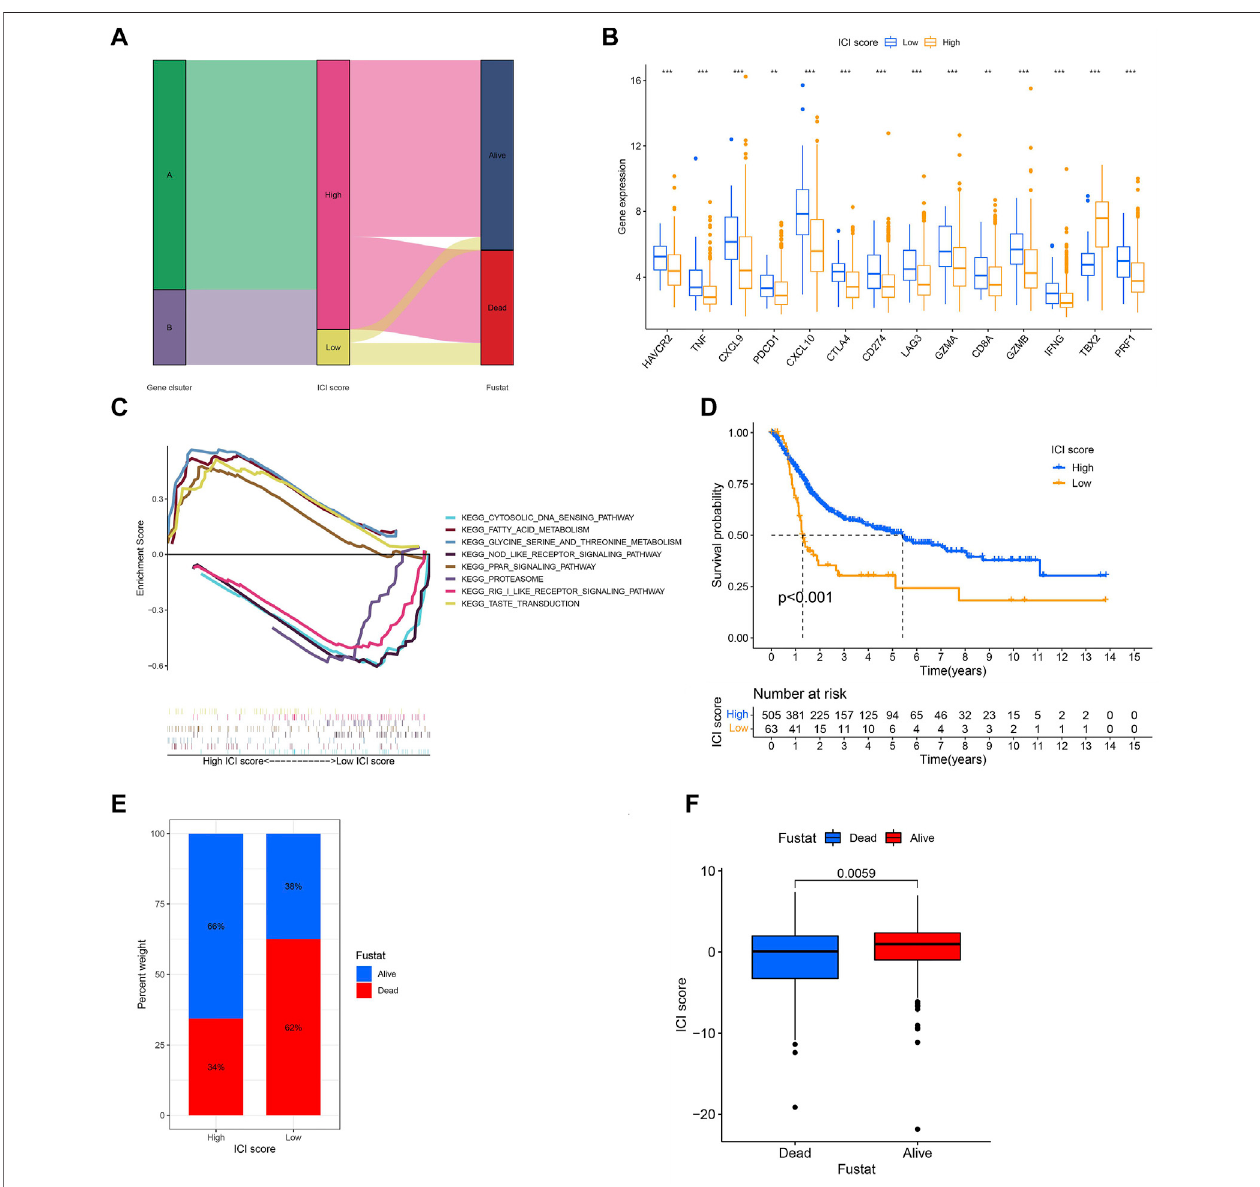
CXCL9, GZMA,GZMB,IFNG,PRF1,TBX2,andTNF)inhighandlowICIscoregroups.* p < 0.05;** p < 0.01,*** p < 0.001; (C) GSEAanalysisresultsexhibitedthatsome signi fi cantly enriched functions or pathways in high and low ICI score groups. (D) Survival time of patients in high and low ICI score groups (log-rank test, p < 0.0010. (E,F) Most of the patients in the high ICI score group were alive; on the contrary, most of the patients in the low ICI score group were dead (log-rank test, p =